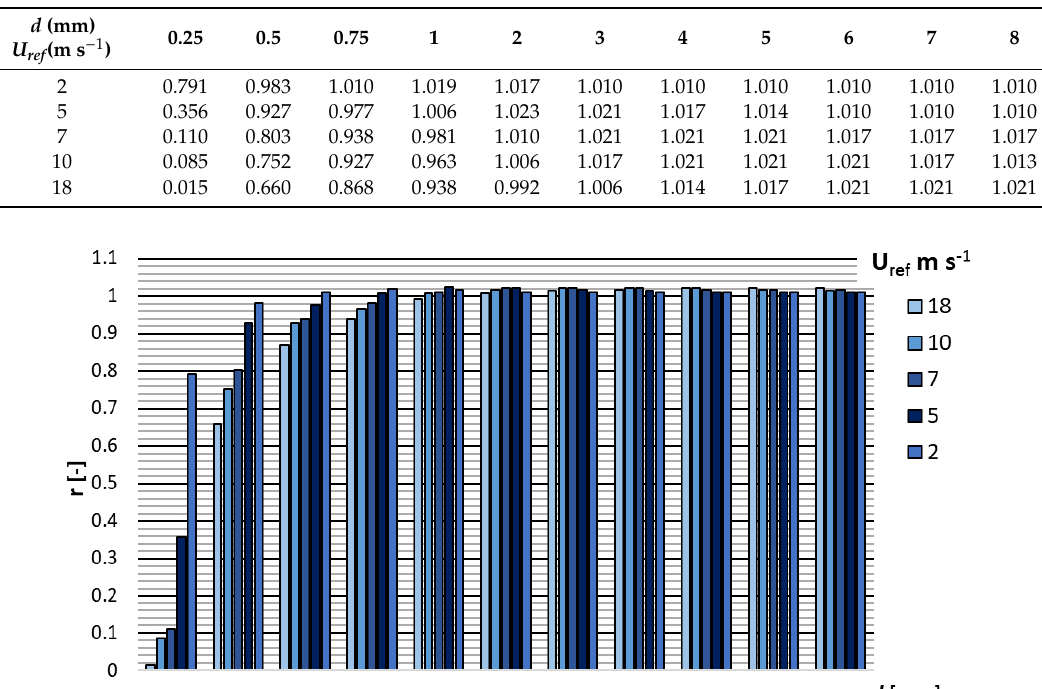
Table 1. Catch ratios for each drop size and at di ff erent wind speed, calculated by means of the LPT model and based on the airflow field simulated for the Casella cylindrical rain gauge.